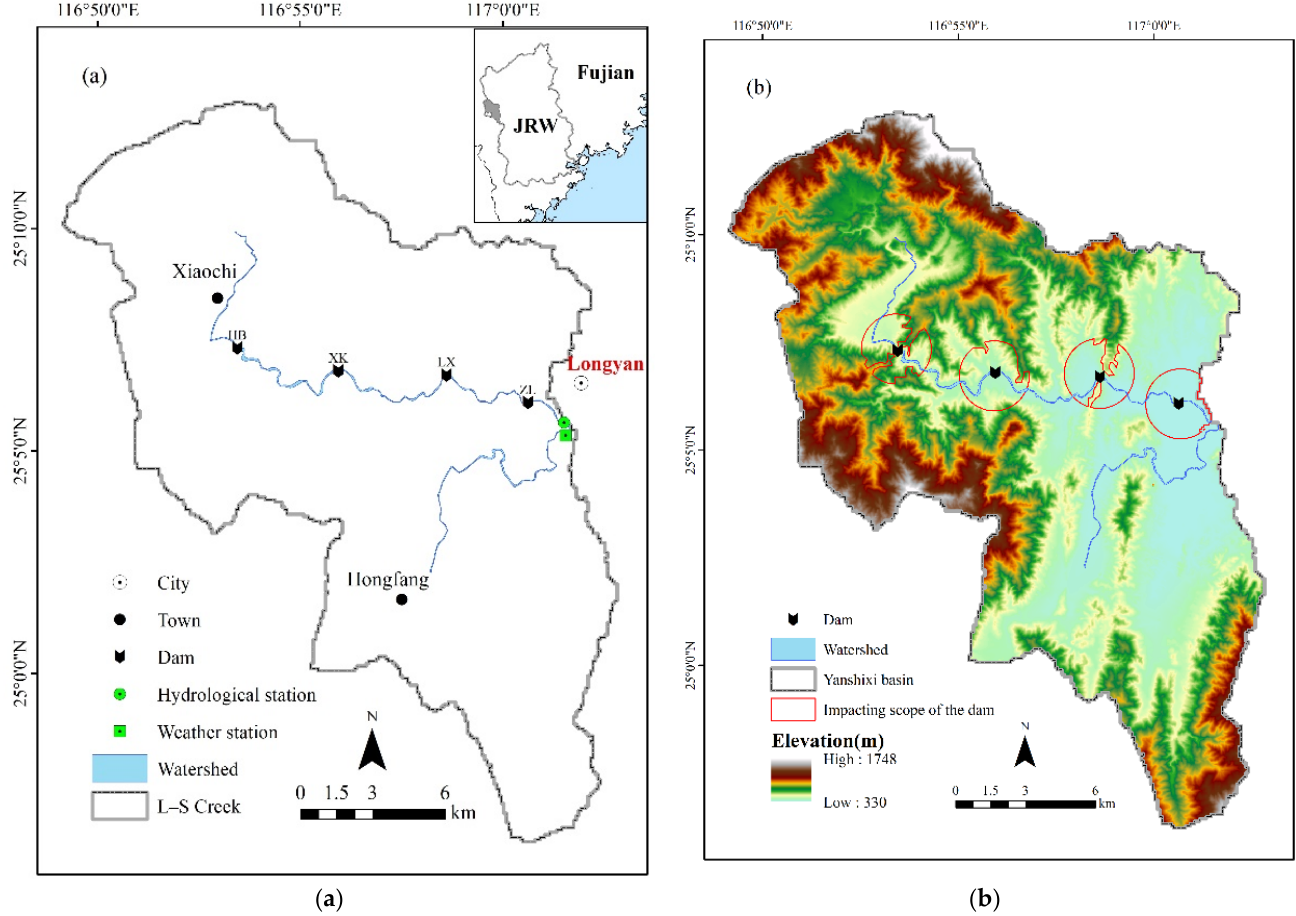
Figure 1. Location of the study area ( a ) and impacted area of dam construction in the L–S Creek ( b ).